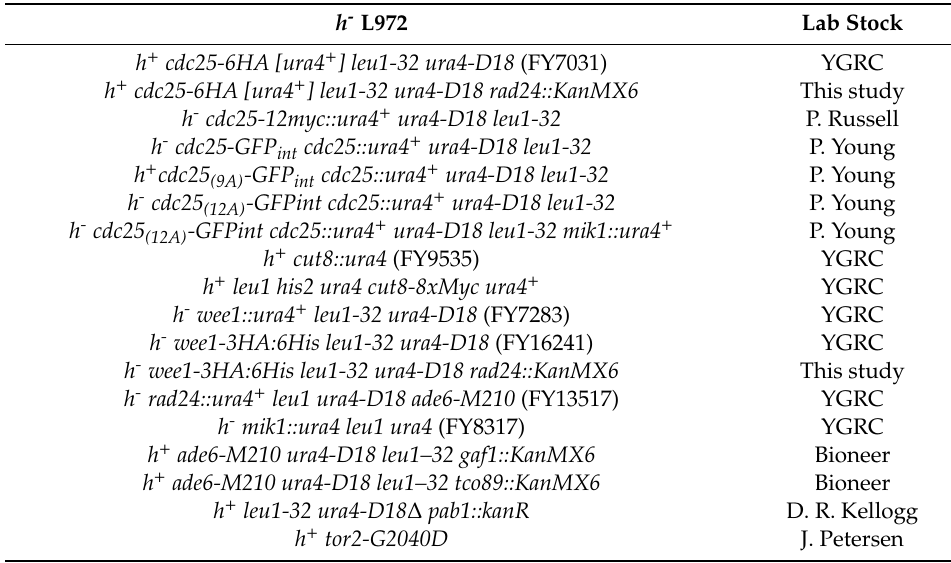
Table 1. S. pombe